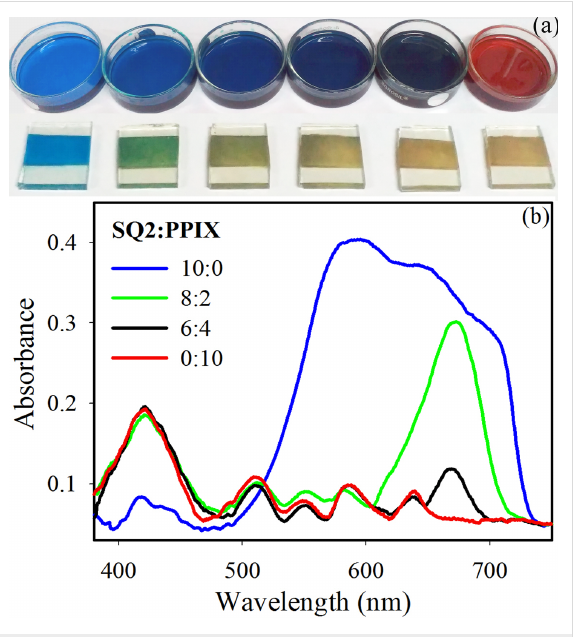
Figure 3: (a) Dye cocktail solutions and dye-sensitized TiO 2 photoan- odes with different molar ratios of SQ2 and PPIX. Starting from left to right the molar ratios of SQ2/PPIX are 10:0, 8:2, 6:4, 4:6, 2:8, 0:10. (b) Reflection-mode absorption spectra of TiO 2 films sensitized with dye mixtures of different molar ratios of SQ2/PPIX.